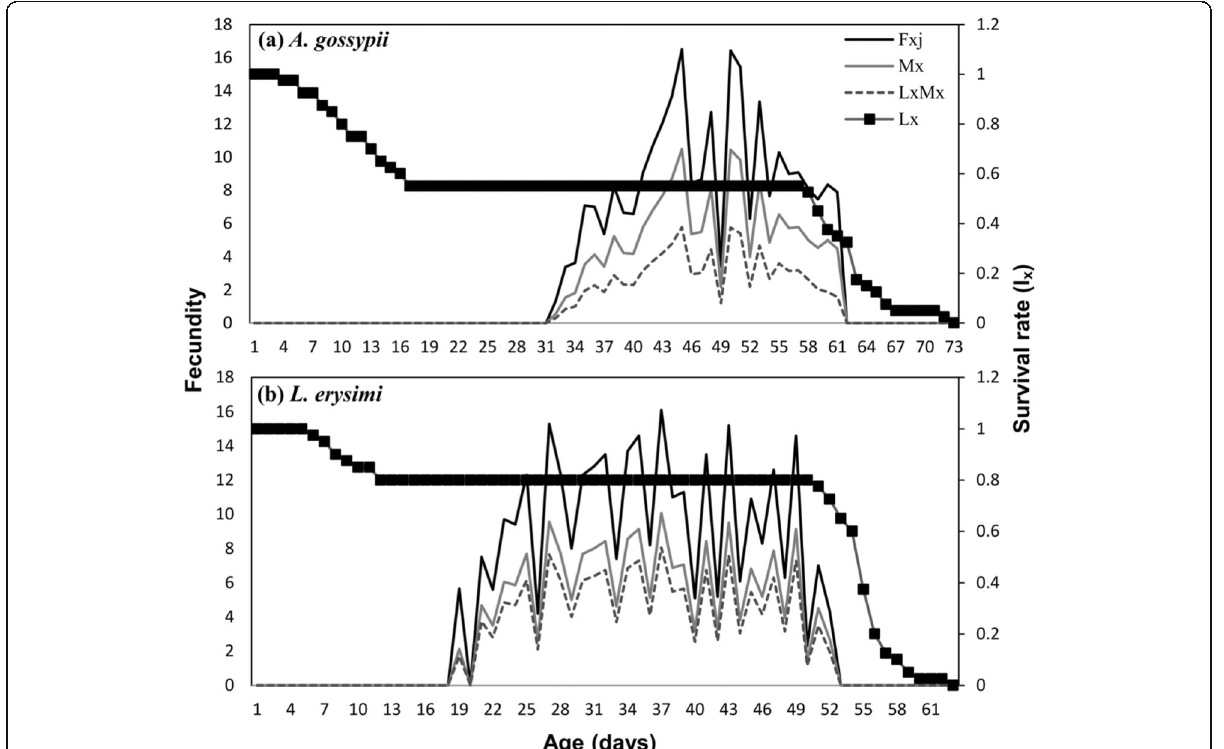
Fig. 3 Age-specific survival rate ( l x), age-stage-specific fecundity ( f xj ), age-specific fecundity (mx), and age-specific maternity ( l x m x ) of Hippodamia convergens fed on two aphid